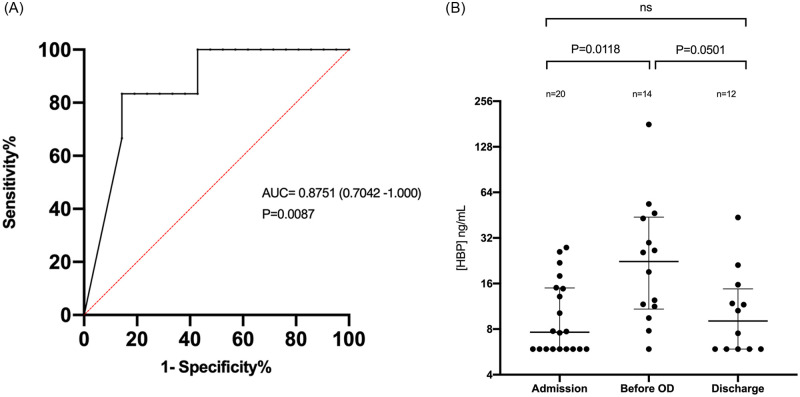
HBP prognosticates organ dysfunction in severe COVID-19.(A) A Receiver operating curve (ROC) of HBP measured by Joinstar point of care test (highest value in the first 72h) predicting organ dysfunction (OD) in severe COVID-19. Area under the curve is 0.86. (B) HBP levels in first sample taken within 72h after admission, within 48h before development of organ dysfunction, and within 48h before hospital discharge measured by the Joinstar point of care test. Samples from patients who developed organ dysfunction within 48h after admission were included in the “before OD” group instead of the “admission” group. Values were compared using Kruskal Wallis test with Dunn’s post-hoc test for multiple comparisons.